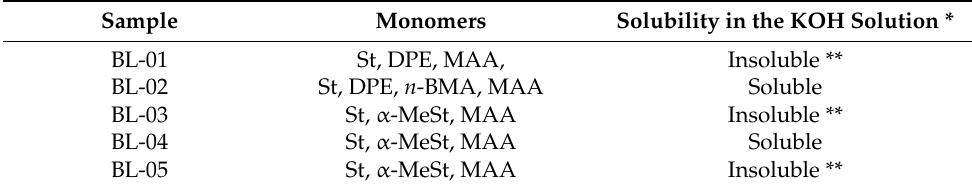
Table 2. Polymer solubility in alkaline aqueous